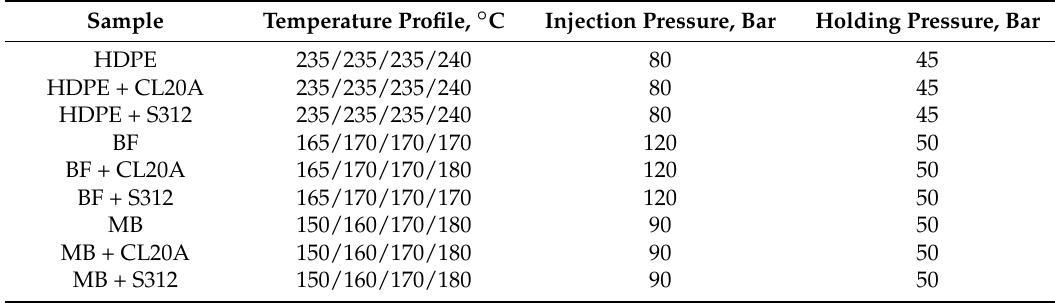
Table 3. Main injection molding process